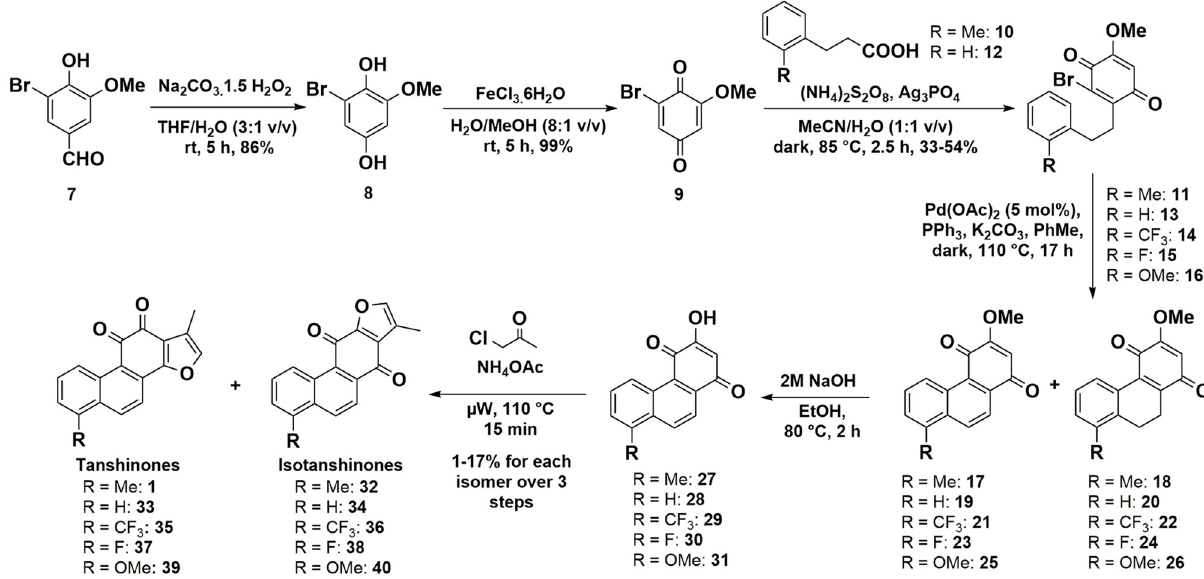
Fig 3. Synthesis of tanshinones and